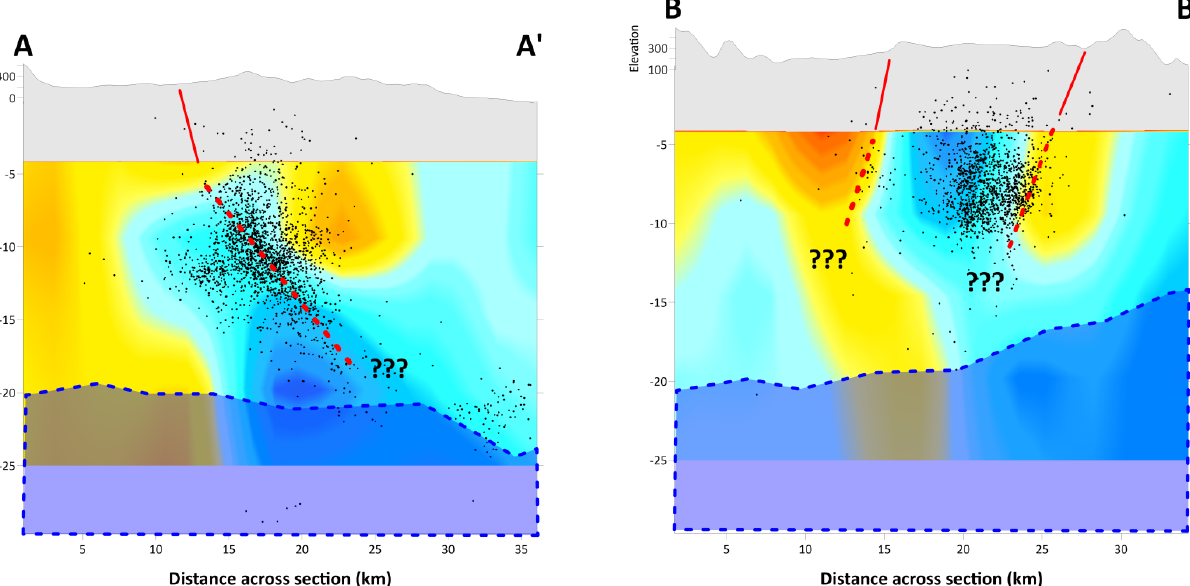
Figure 8. Cross-sections of V P (%) perturbations. The cross-section traces are the same with the first four ones of Figure 5.